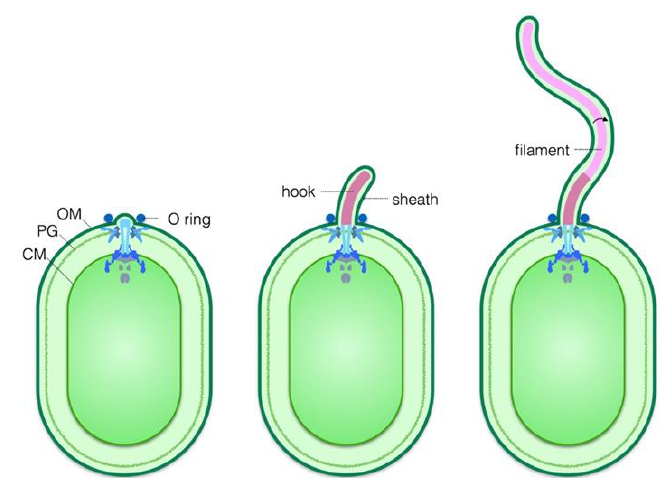
Figure 3. A schematic of assembly and sheath formation of a sheathed flagellum of Vibrio alginolyticus. The O-ring is assembled on the exterior side of the outer membrane at the point where the nascent flagellar sheath emerges. As the hook and filament are assembled, the flagellar sheath extends to encase these structures. The O-ring remains positioned at the base of the flagellar sheath where it stabilizes or induces a sharp bend in the outer membrane as it transitions into the flagellar sheath. The outer (OM), cytoplasmic membranes (CM), and peptidoglycan (PG) are